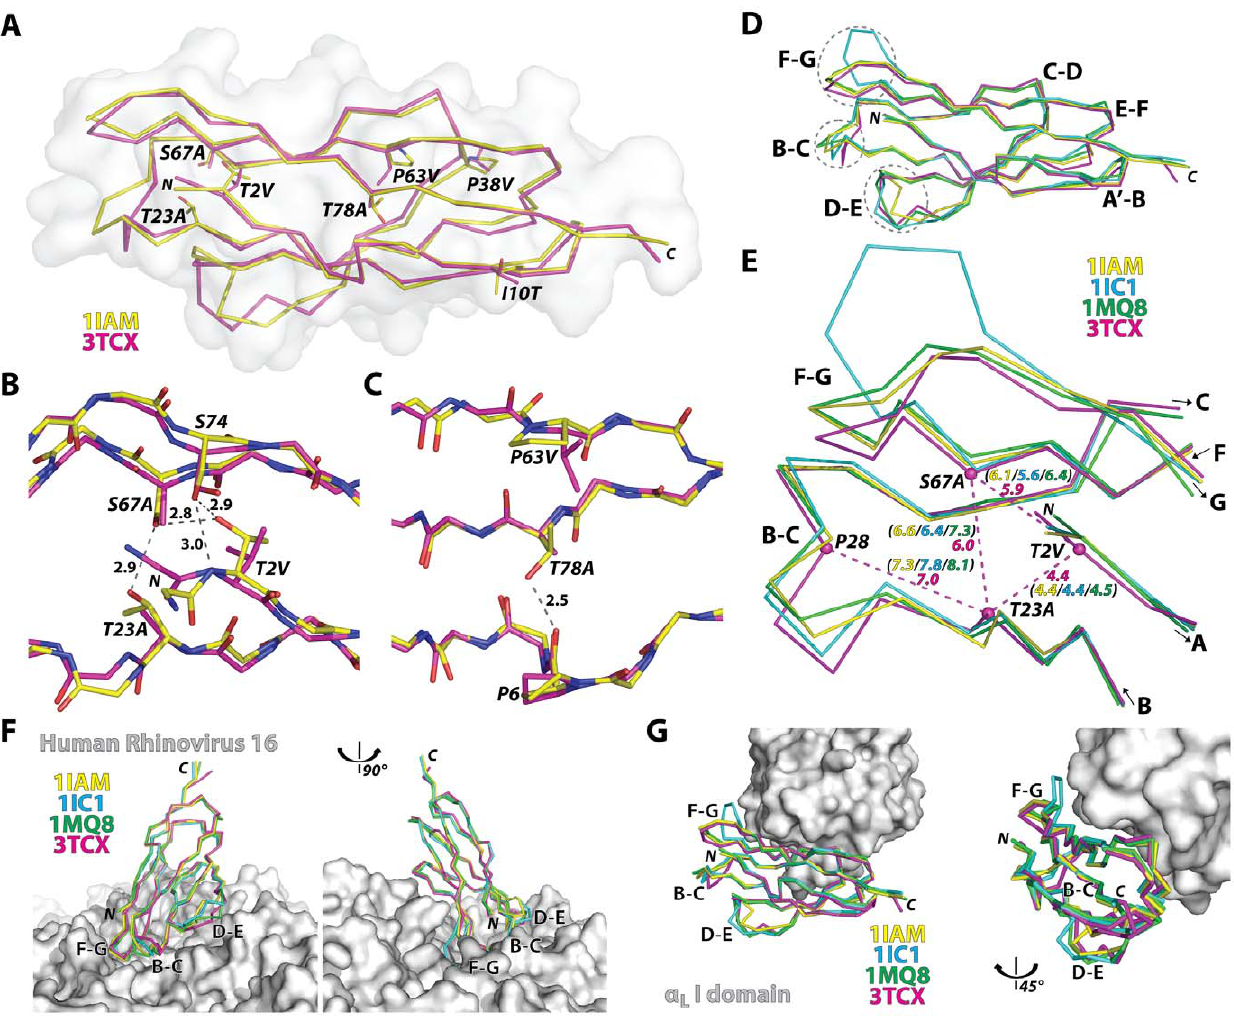
Figure 3. Structural deviation in engineered ICAM-1 D1 and its implication in ICAM-1 interaction with LFA-1 and HRV. (A) C a -traces of engineered ICAM-1 D1 (magenta) and the wild-type D1 in D1D2 fragment (1IAM in yellow) are drawn with solvent-accessible surface plot (grey). (B) Hydrogen bond network formed by Thr-2, Thr-23, Ser-67, and Ser-74 at the N-terminal protein core is shown in grey dotted lines with distances in A˚ from the wild-type ICAM-1 structure (1IAM). Substitutions of T2V, S67A, and T23A in D1 are indicated. (C) A hydrogen bond between Pro-6 and Thr-78 is shown with a dotted line. Substitutions of P63V and T78A found in D1 are indicated. (D) D1 structures of the previous ICAM-1 D1D2 structures (1IAM in yellow [15], 1IC1 in blue [24], 1MQ8 in green [17]) were superimposed to engineered D1 (3TCX in magenta). The loops, B–C, D–E, and F–G, are circled with dotted lines. (E) The distances between the C a atoms (dotted lines in magenta) of the triad Thr-2, Thr-23, and Ser-67, and the C a distance between Pro-28 to Thr-23 in previous structures are compared with those in D1 mutant. (F) The superimposed ICAM-1 structures with the HRV were modeled based on the cryo-EM C a coordinates of ICAM-1 D1D2 bound to HRV16 (1D3E [31] and 1AYM [45]). (G) The superimposed D1 structures are shown with the a L I domain shown as solvent-accessible